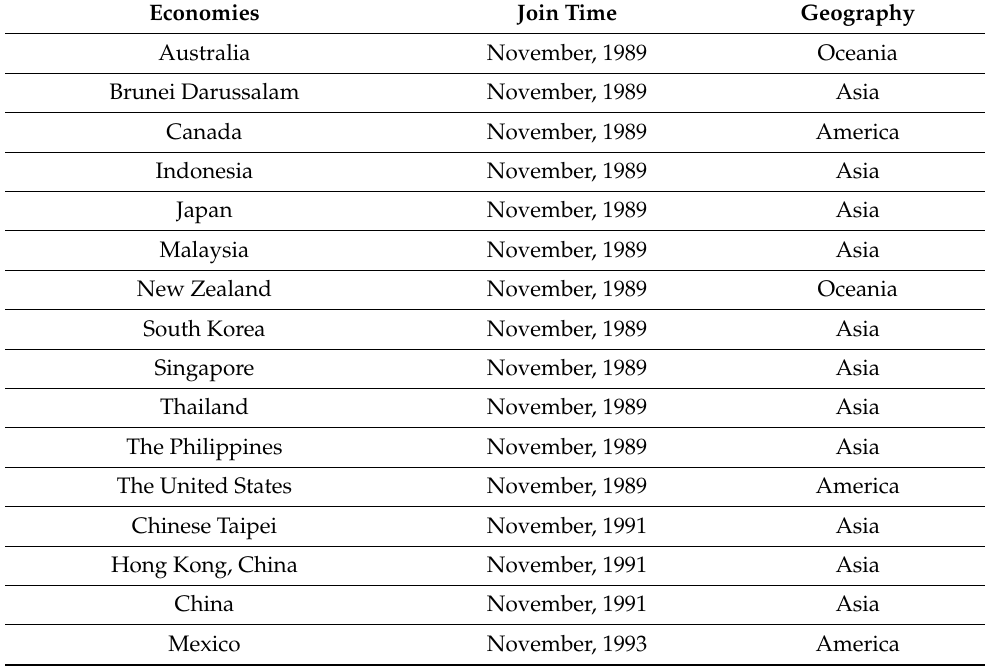
Table 3. The summary of the APEC economies.